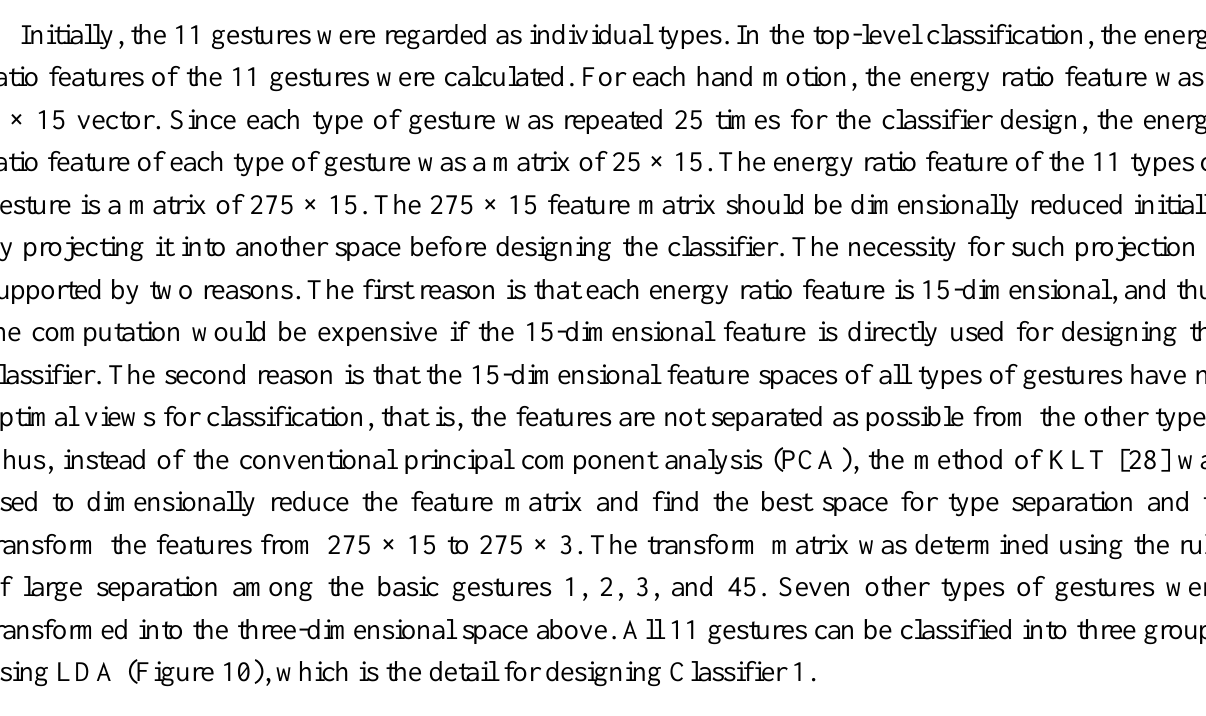
Figure 10. Classifier 1 in the top-level of the first